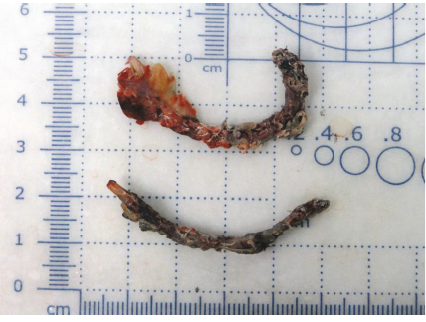
Figure 2: Gross specimen of